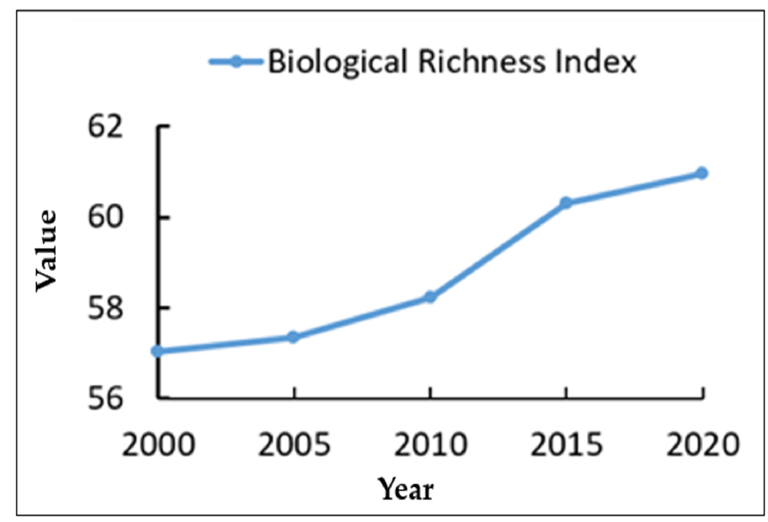
Figure 7. The change of biological richness index in Rangtang County.